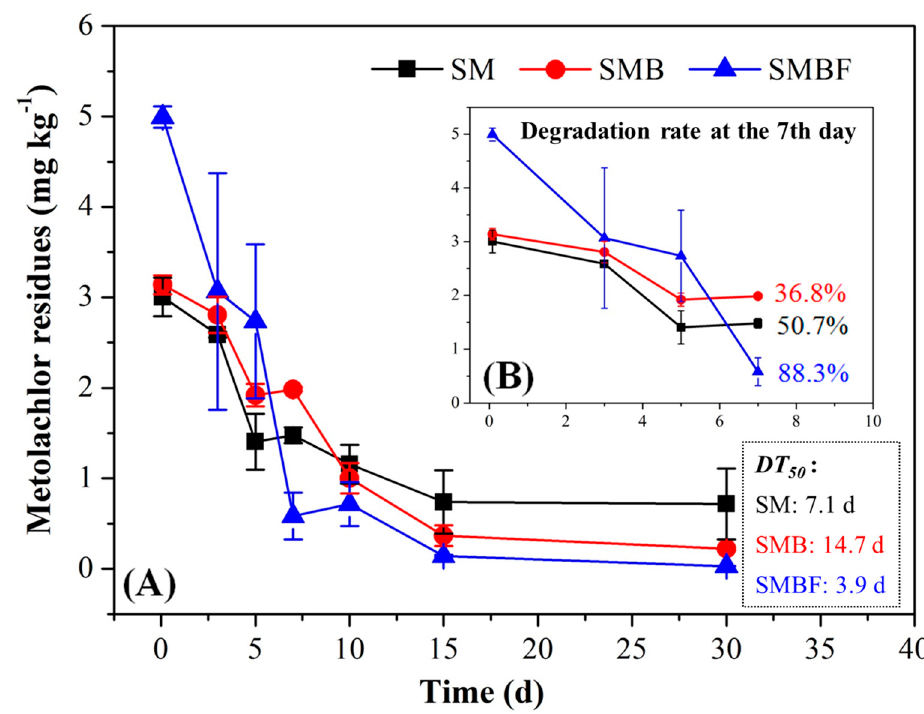
Figure 7. Degradation of metolachlor in field soils by wheat bran inoculants of MET-F-1 within 30 days ( A ), and the degradation curve within 7 days was magnified ( B ). SM, only application with 720 g/L metolachlor EC at the recommended dosage (5.0 mL/20 m 2 ); SMB, application with 720 g/L metolachlor EC, and the wheat bran at the ratio of 4 kg/20 m 2 ; SMBF, application with 720 g/L metolachlor EC, and the microbial inoculum of strain MET-F-1 at the ratio of 4 kg/20 m 2 .